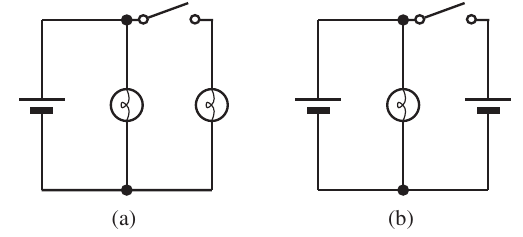
FIG. 8. Circuits used to highlight the similarities and differ- ences between connecting in parallel with a bulb and battery (a) a second bulb and (b) a second